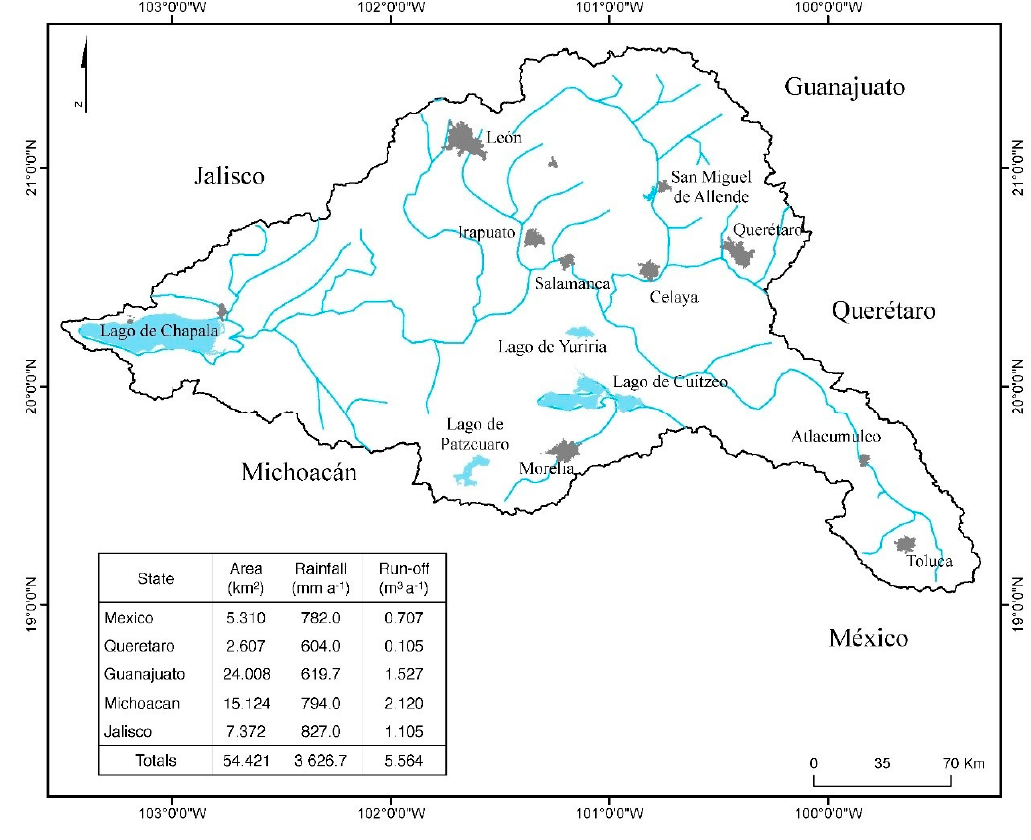
Figure 3. The Lerma–Chapala river basin. Source: own construction (built by Oscar Salvatore), constructed following [72].